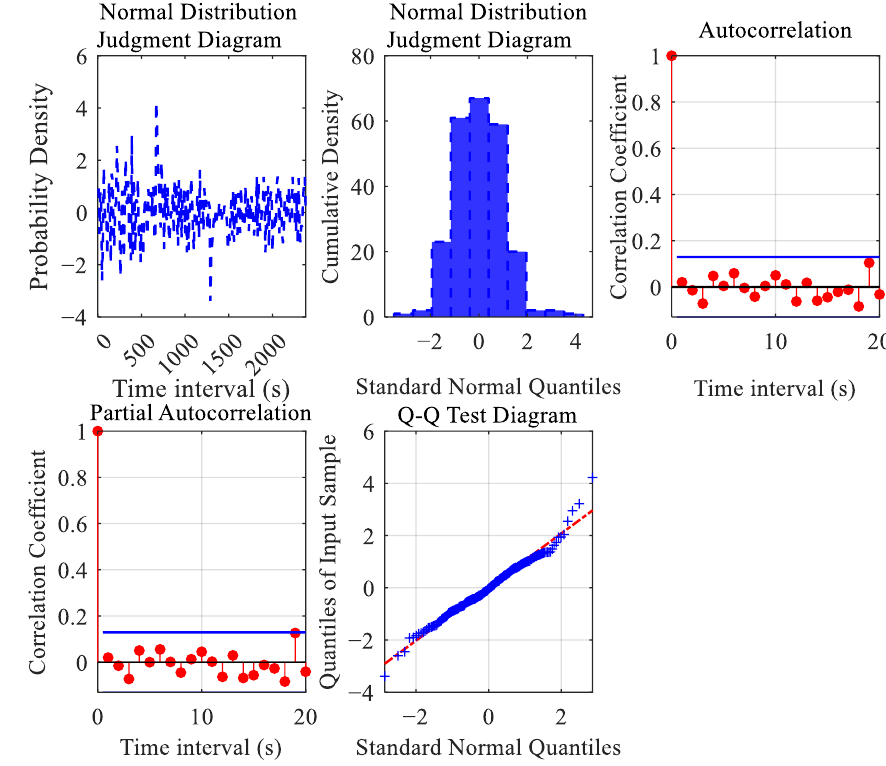
Figure 9. Visualization for the stability test of passenger flow entering the station.